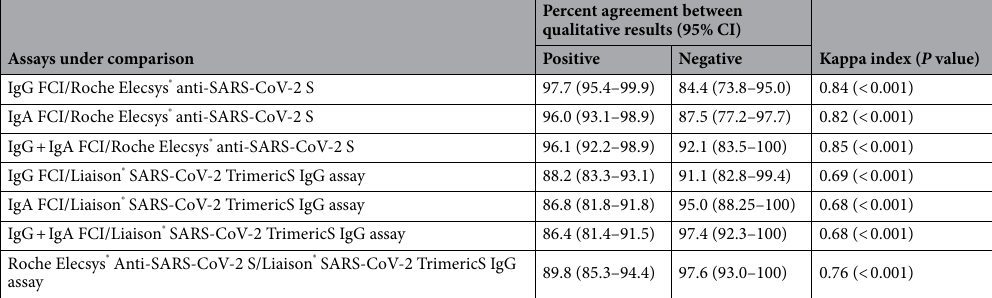
Table 4. Agreement between qualitative results provided by flow cytometry-based S immunoassay and two commercially-available SARS-CoV-2 CLIA targeting either the trimeric S protein or the receptor binding domain (RBD). FCI flow cytometry